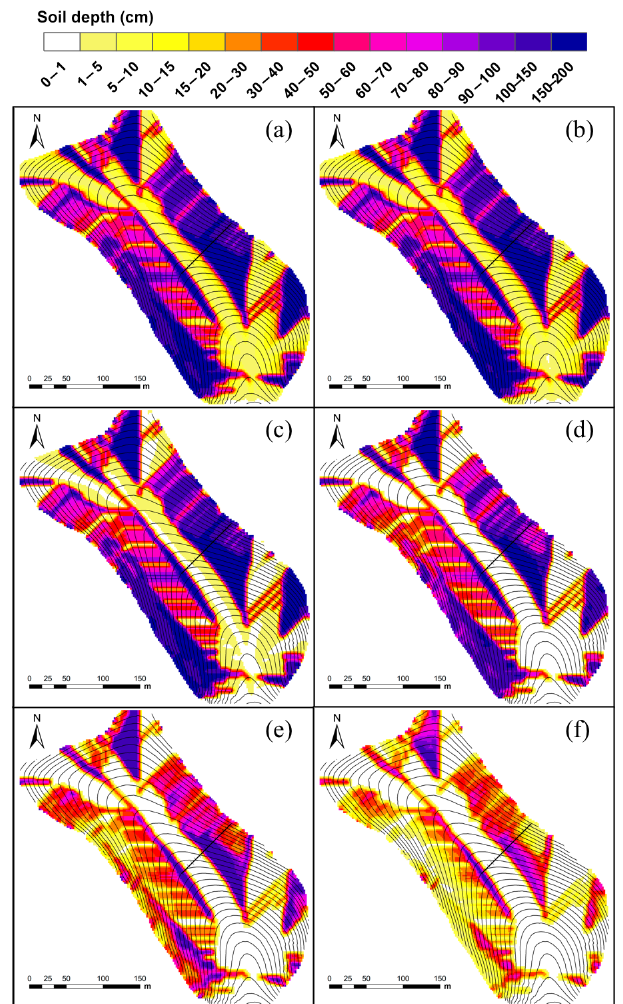
Figure 6. Soil depth maps produced by the combined simula- tion (S3) at 3.2kyr time intervals in the last 18 of 80kyr simu- lated: (a) 18kyrBP, (b) 12.8kyrBP (end of P1), (c) 9.6kyrBP, (d) 6.4kyrBP (end of P2), (e) 3.2kyrBP, and (f) 0kyrBP (fi- nal/modern end of P3). The contour lines represent 2m change in